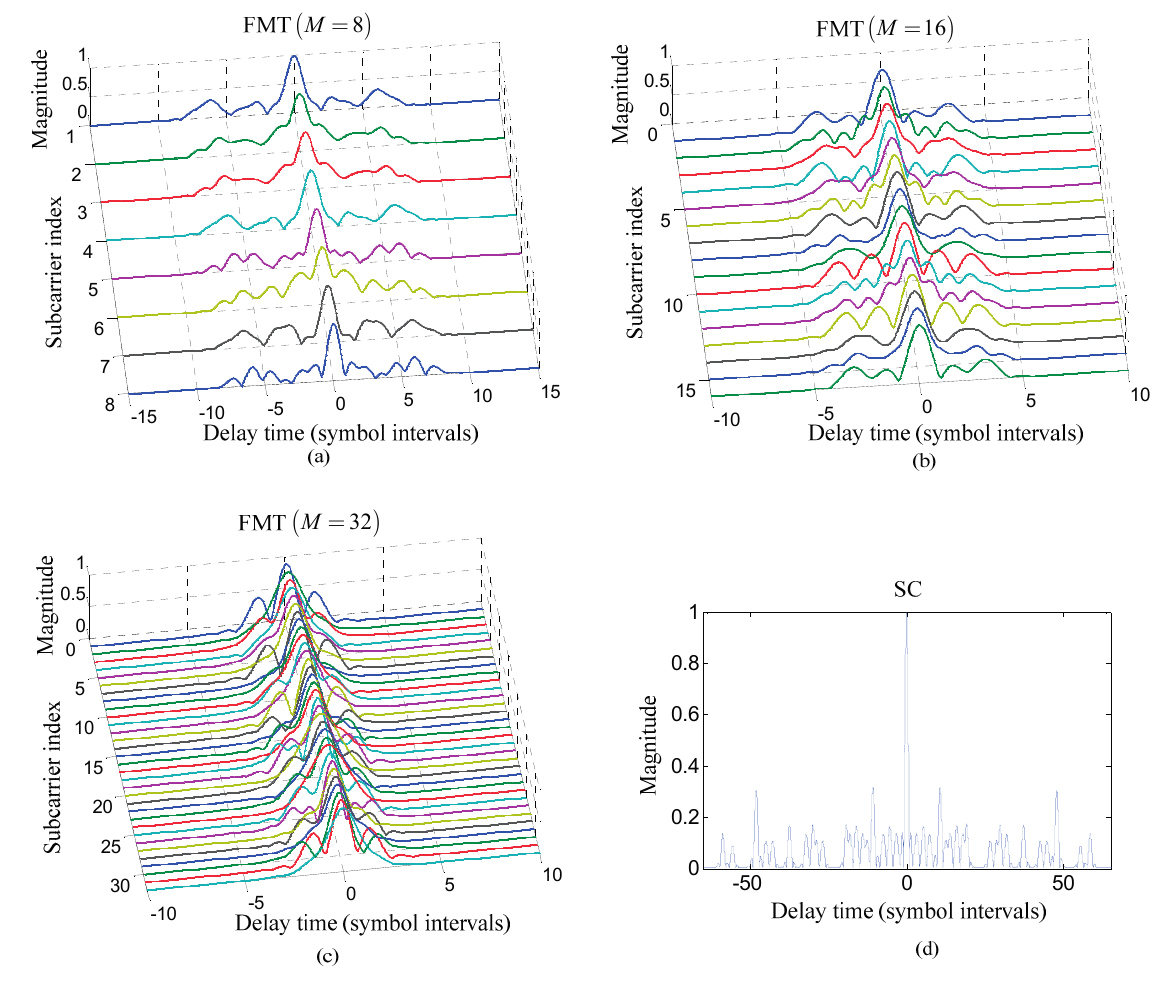
Figure 4. Comparison of the time domain response of each composite channel from the transmit filter to the matched filter for the TR process between two